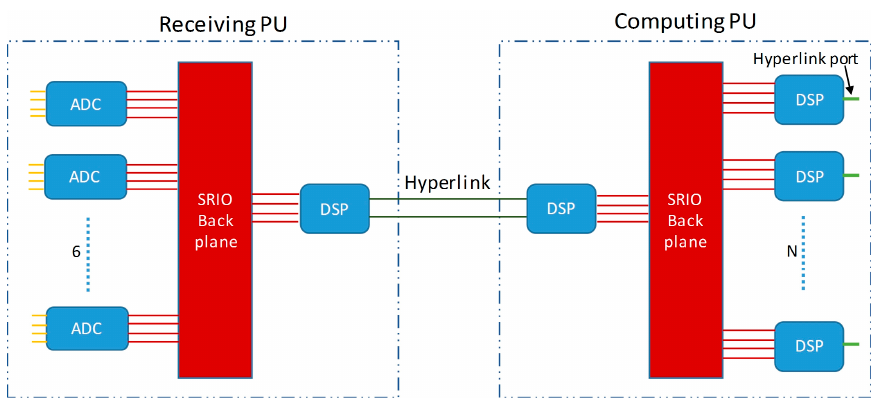
Figure 4. Simple example of a processing unit (PU)-based architecture.